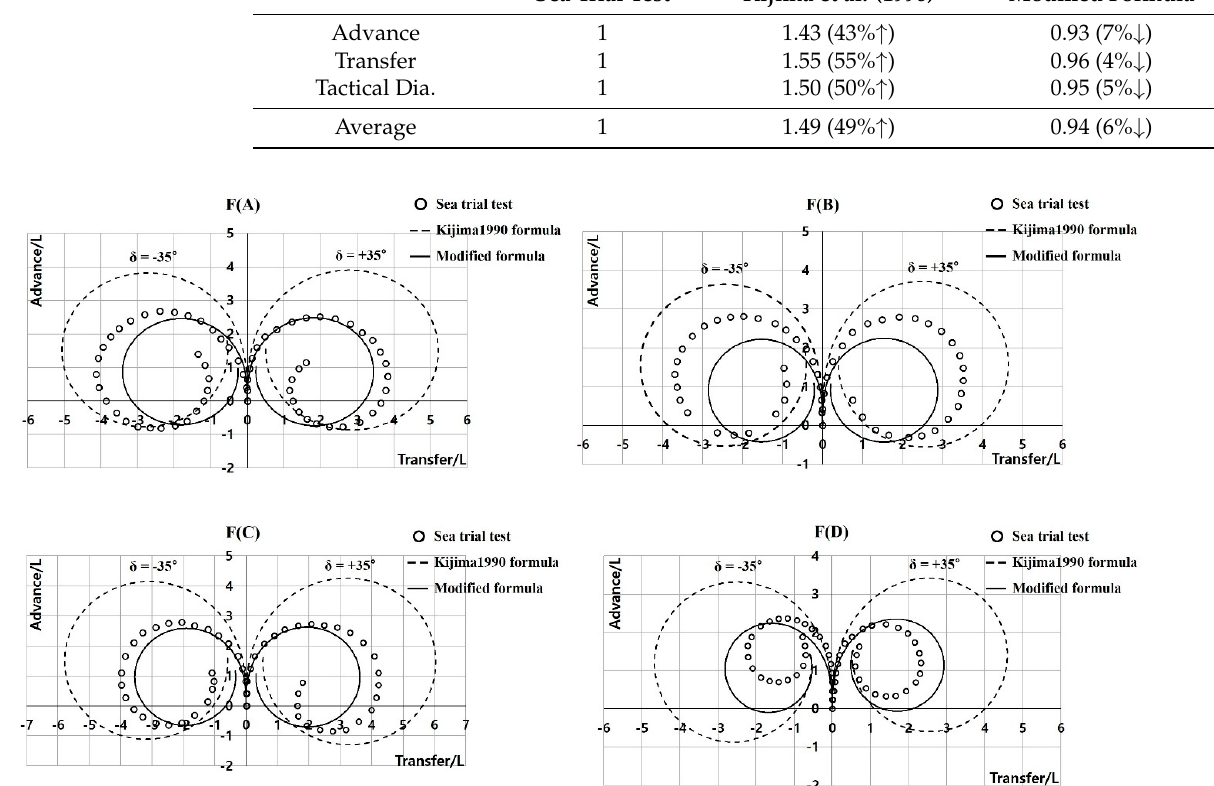
Figure 5. Comparison of the turning motion test results of the model trawl fishing vessels.